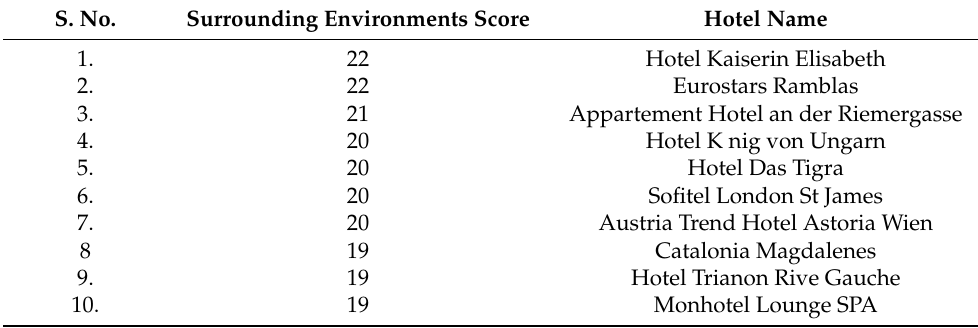
Table 10. Top-10 recommended hotels for the 1493 hotels of Booking based on surrounding environments. S. No.